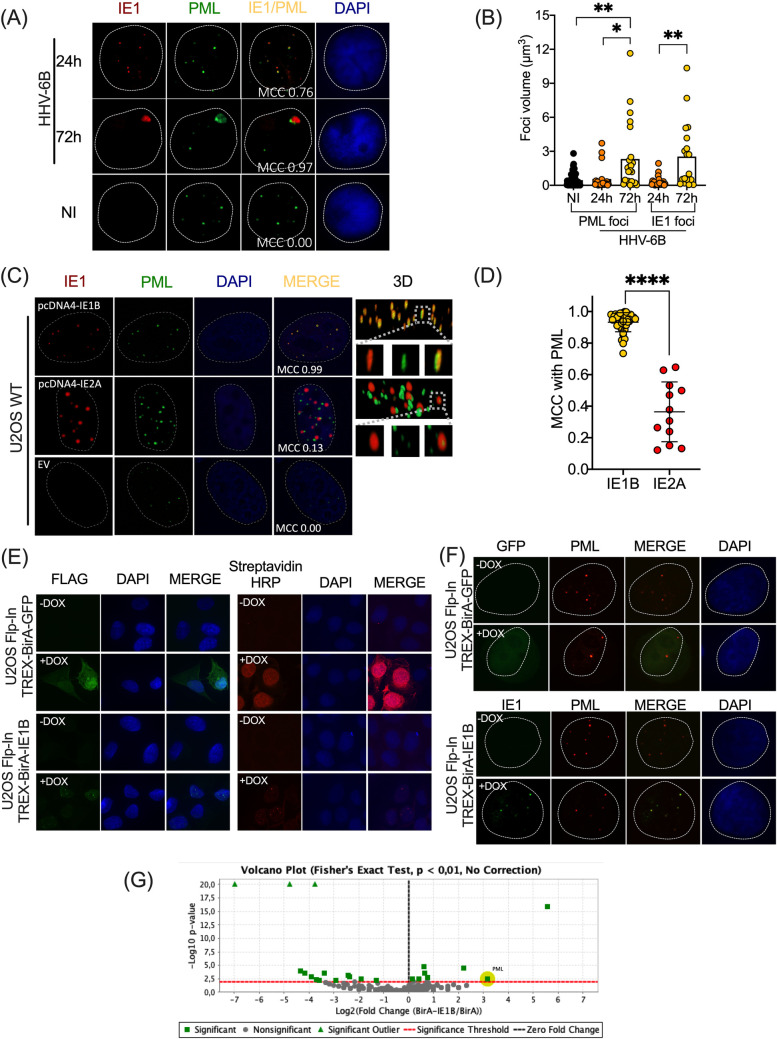
IE1 associates with PML during infection and in the absence of other HHV-6B proteins.(A) Confocal microscopy of IF images representing PML-NBs in non-infected (NI) MOLT-3 cells and infected with HHV-6B for 24 and 72h, acquired at 40X. Colocalization is presented for each time point. PML was detected using anti-PML with an anti-mouse-ALEXA-488 antibodies (green) and infected cells were detected with IE1 expression using anti-IE1-ALEXA-568 (red). (B) Graph showing the volume of PML and IE1 foci during infection. *P<0.01; **P<0.006, Kruskal-Wallis test (One-Way ANOVA with multiple comparisons). (C) Confocal microscopy of IF images representing ectopically expressed IE1 colocalizing with endogenous PML in U2OS cells, acquired at 63X. Cells were transfected with pcDNA4/TO-IE1B, pcDNA4TO-IE2A or pcDNA4/TO (EV: Empty Vector) vectors for 48 hours. IE1 and PML were detected with the same antibodies used in Fig 1A. IE2 was detected using anti-IE2-ALEXA-568 (red). 3D reconstitutions of deconvoluted acquisitions show perfect colocalization of IE1 with PML, represented by the yellow color. (D) Graph of MCC of IE1 (n = 39) and IE2A (n = 12) foci colocalizing with PML. Each dot represents a nucleus. ****P<0.0001, Mann-Whitney test. (E) U2OS-Flp-In TREX cells were co-transfected with pcDNA5/TO expression vectors containing FLAG-BirA-GFP or FLAG-BirA-IE1B with pOG44 (flipase) and selected with hygromycin (250μg/ml) and blasticidin (50μg/ml). IF confirms BirA-GFP and BirA-IE1B expression (Flag) and biotinylation of proteins (Streptavidin-HRP-594) when induced with doxycycline. (F) Stable U2OS-BirA-GFP and U2OS-BirA-IE1 cells were induced or not with doxycycline and colocalization of IE1 with PML is demonstrated following PML and FLAG labelling. (G) Volcano plot of IE1 specific interacting partners following mass spectrometry and a Fisher’s Exact test to identify specific IE1 interacting partners. PML was one of the specific interacting IE1 partner, compared to BirA alone, with a p value of P<0.0034.